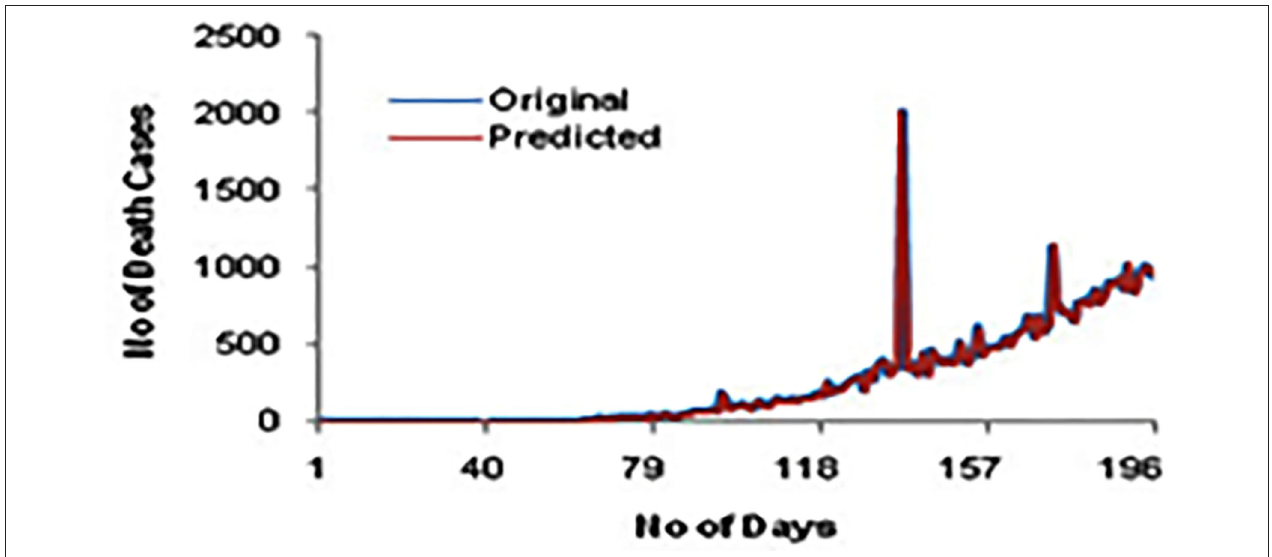
FIGURE 5 | Predicted values for death cases.